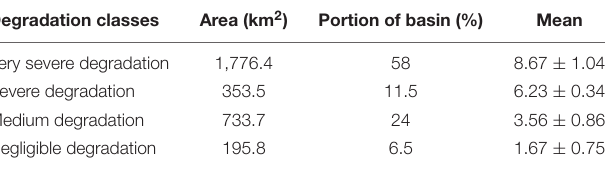
TABLE 5 | Area and mean degradation scores of the different degradation classes. Degradation classes